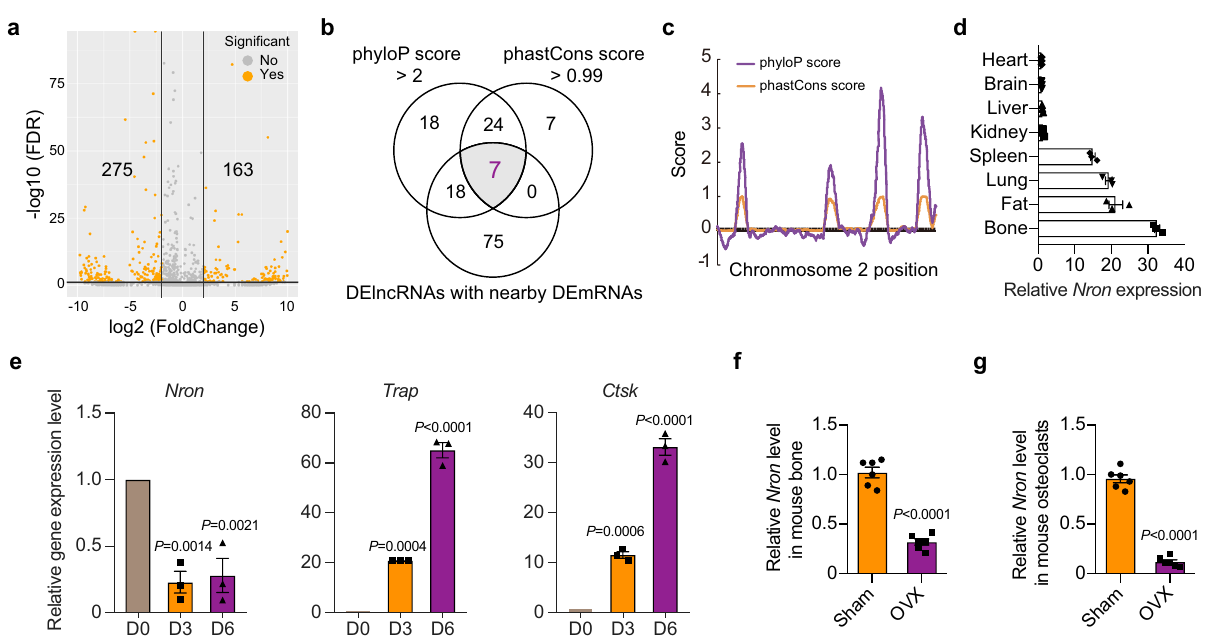
Fig. 1 Identi fi cation of Nron as a candidate regulatory lncRNA in osteoclasts. a Volcano plots of the differential lncRNAs expression in undifferentiated BMMs and BMMs-derived osteoclasts. b Venn diagram representing the selection strategy for conserved lncRNAs. c PhastCons and PhyloP score of Nron. d Q-PCR analysis of Nron expression in eight types of C57BL/6 J mouse tissue, ( n = 3/group). e Q-PCR analysis of Nron , Trap , and Ctsk gene expression levels during BMMs osteoclast differentiation, ( n = 3 biologically independent experiments). f Q-PCR analysis of Nron expression in whole bone specimens (without bone marrow) from sham and ovariectomized (OVX) mice, ( n = 6/group). g Q-PCR analysis of Nron expression in CTSK + osteoclasts isolated by microdissection from Sham and OVX mice, ( n = 6/group). Signi fi cant differences between two groups were determined by unpaired Student ’ s t -test (two- tailed) and signi fi cant differences among multiple groups were determined by one-way ANOVA with Dunnett ’ s multiple comparisons test. Data are presented as the means ± s.e.m. Source data are provided as a Source Data fi